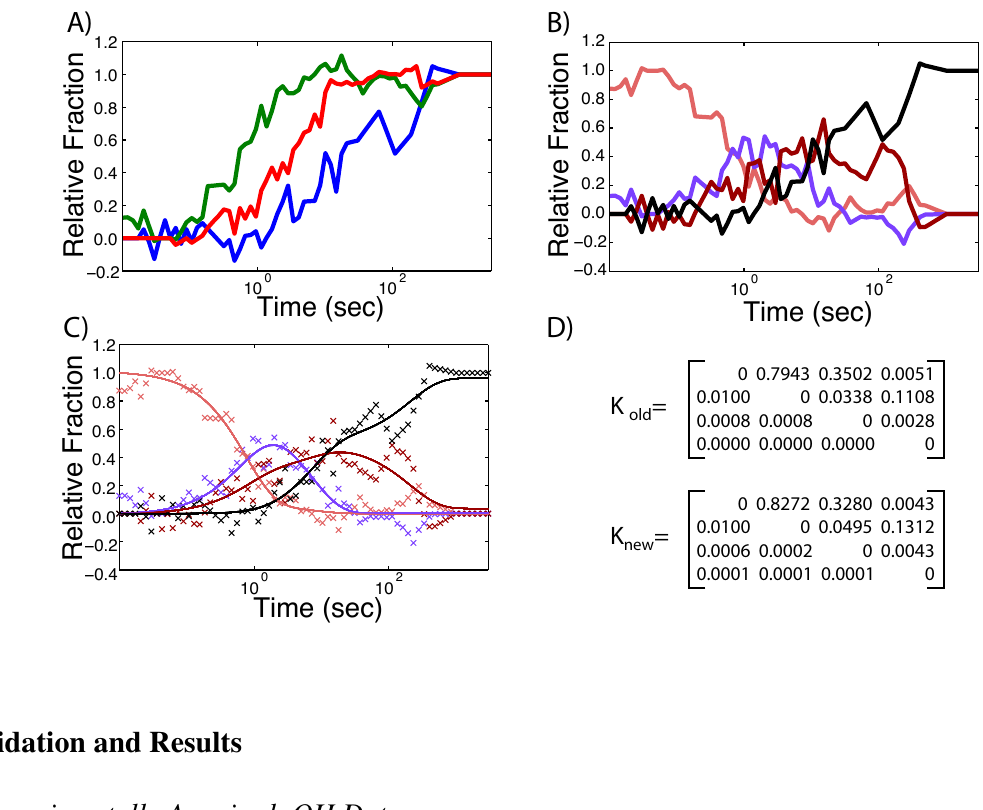
Figure 4. Illustration of current algorithm when applied to actual experimentally obtained · OH footprinting data; curve colors are consistent with Figure 1. A) Time-progress curves with experimental noise. B) Resulting state curves (cid:126)x ( t ) determined by applying Equation 9 to the raw data and only selecting the P matrices that satisfy the AUC criteria. C) Optimized fit using non-linear least squares minimization of K of state curves. D) K matrices obtained using the old and new approaches to determining P and K , which yield identical results within error. Error on the rate values vary between 5 and